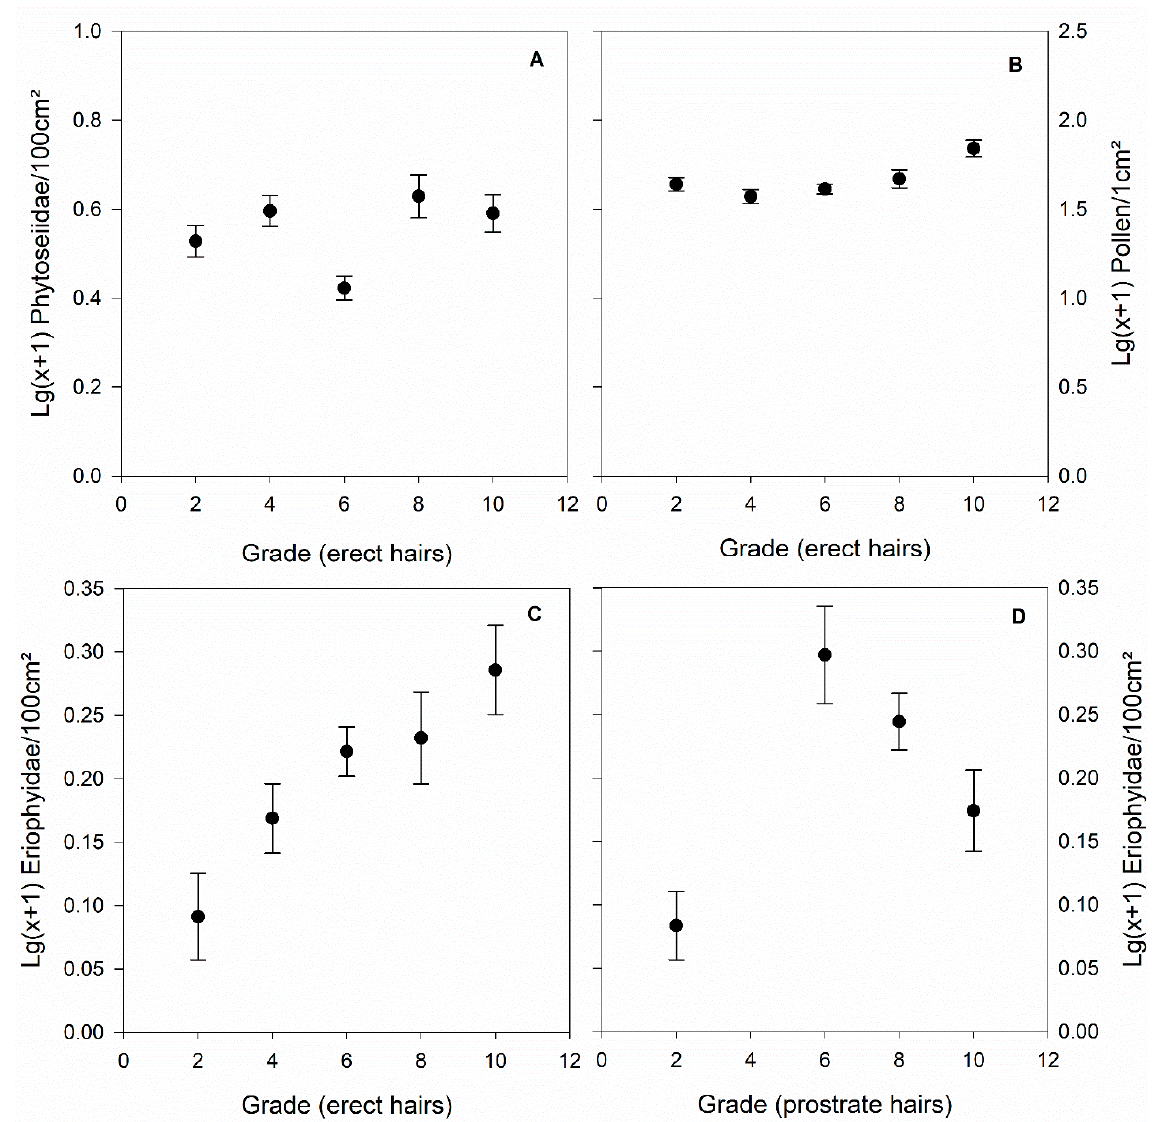
Figure 2. Significant influence of erect and prostrate hair grades of the leaf underside on phytoseiid ( A ) and eriophyid ( C , D ) abundance and pollen deposition ( B ) (mean ± SE) in vineyards sampled by [1]. Figures visualizing all significant explanatory variables in GLMs on phytoseiid, tydeid and eriophyid abundance as well as pollen deposition are provided in the Supplementary File (Figures S1a,b, S2a,b, S3 and